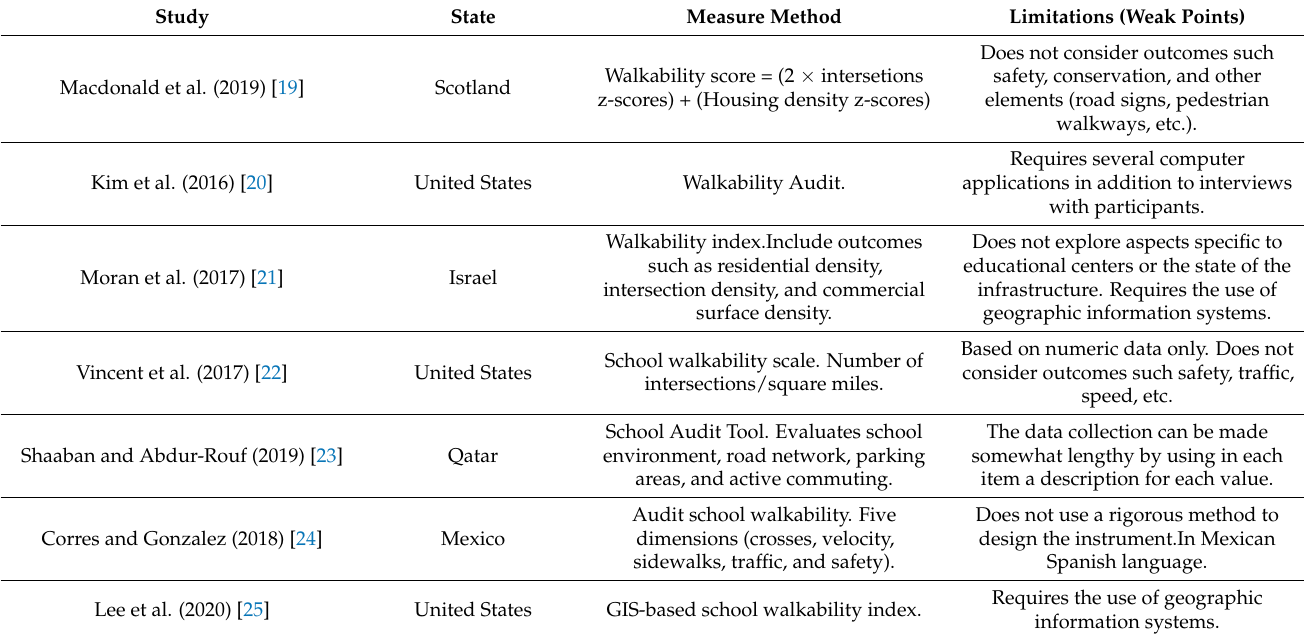
Table 1. Methods for measuring walkability in school